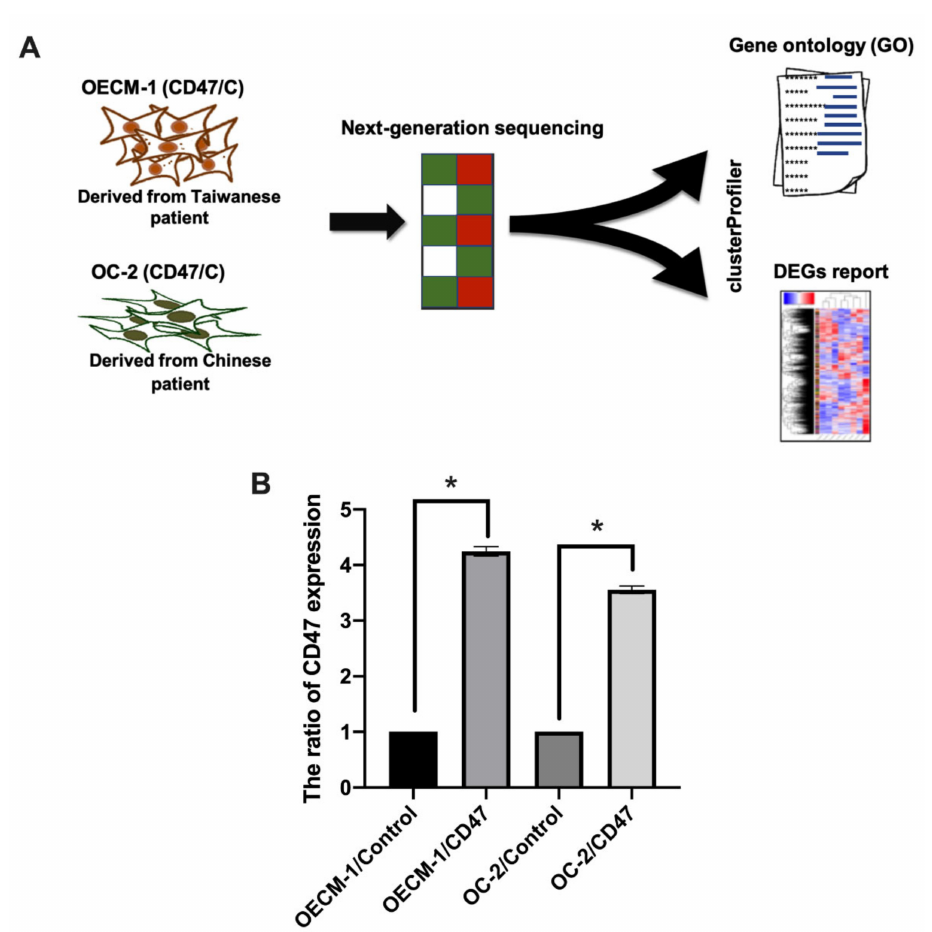
Figure 1. Investigation of CD47 expression in OECM-1 and OC-2 cells. ( A ) The flow chart shows the method of studying various gene expression changes with overexpressed CD47 in OECM-1 and OC-2 cells, through a gene expression array. The clusterProfiler tool was used to analyze bioinformatic approaches including gene ontology (GO) and DEGs. ( B ) Overexpression of CD47 was performed by transfecting cells with CD47 plasmid (1 µ g), and CD47 expression was detected with qPCR and compared to the empty control. The data are presented as the mean ± standard deviation (SD) of three experiments. The data are presented as the mean ± SD of three experiments. * p < 0.05 vs. empty control; two-tailed Student’s t